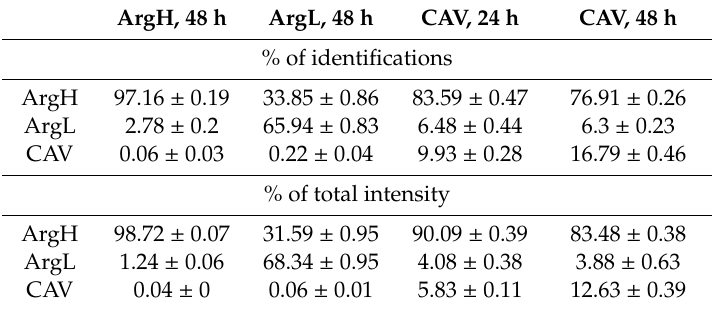
Table 1. Incorporation of arginine (Arg) and canavanine (CAV) into proteins of U251MG cells under examined